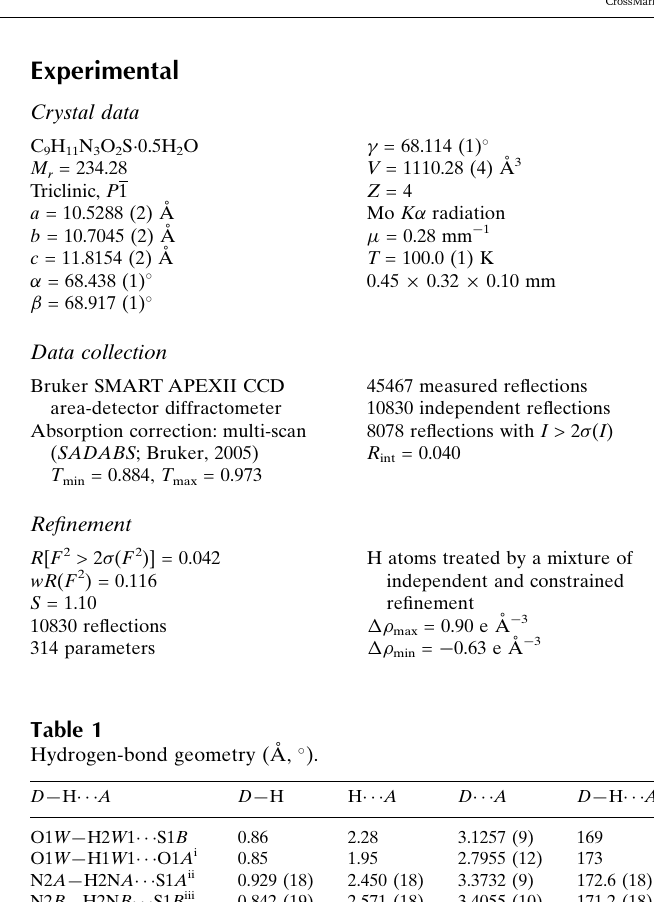
H N O S (cid:1) - 9 11 3 2 Hydrogen-bond geometry (A˚ , (cid:2) ). D —H (cid:1)(cid:1)(cid:1) A Symmetry